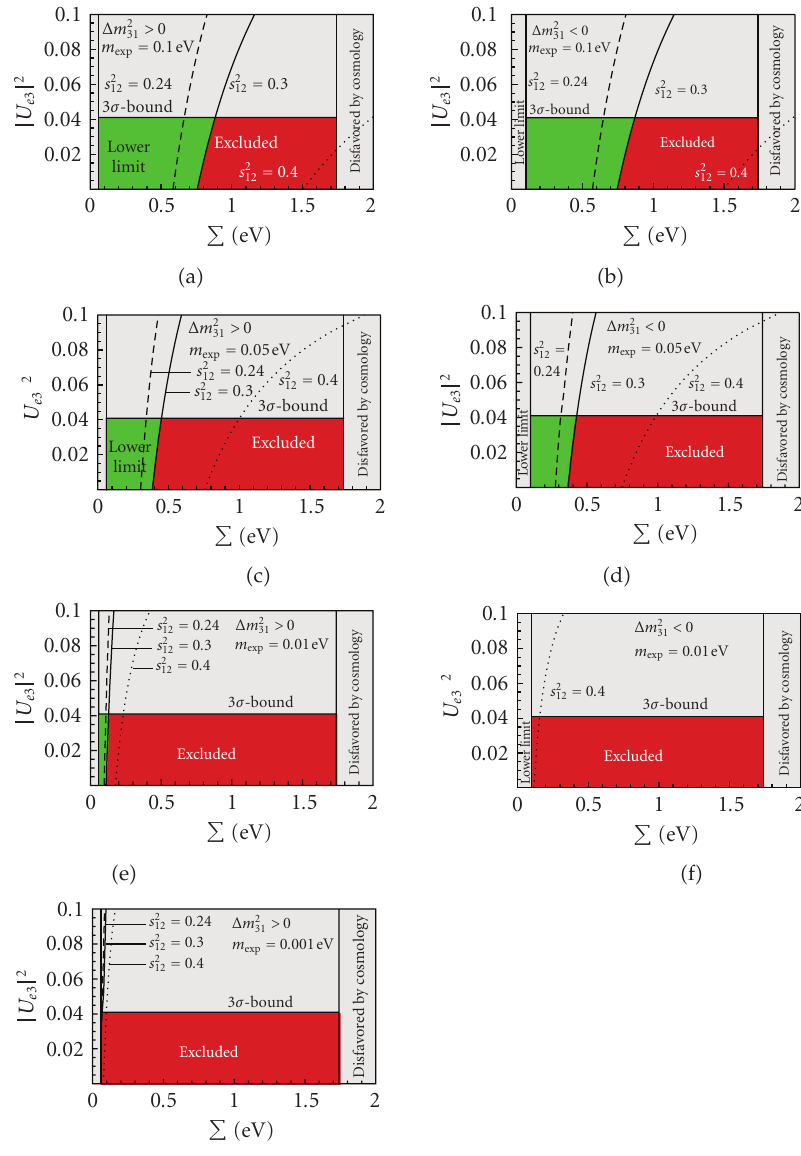
(cid:20) m i for a